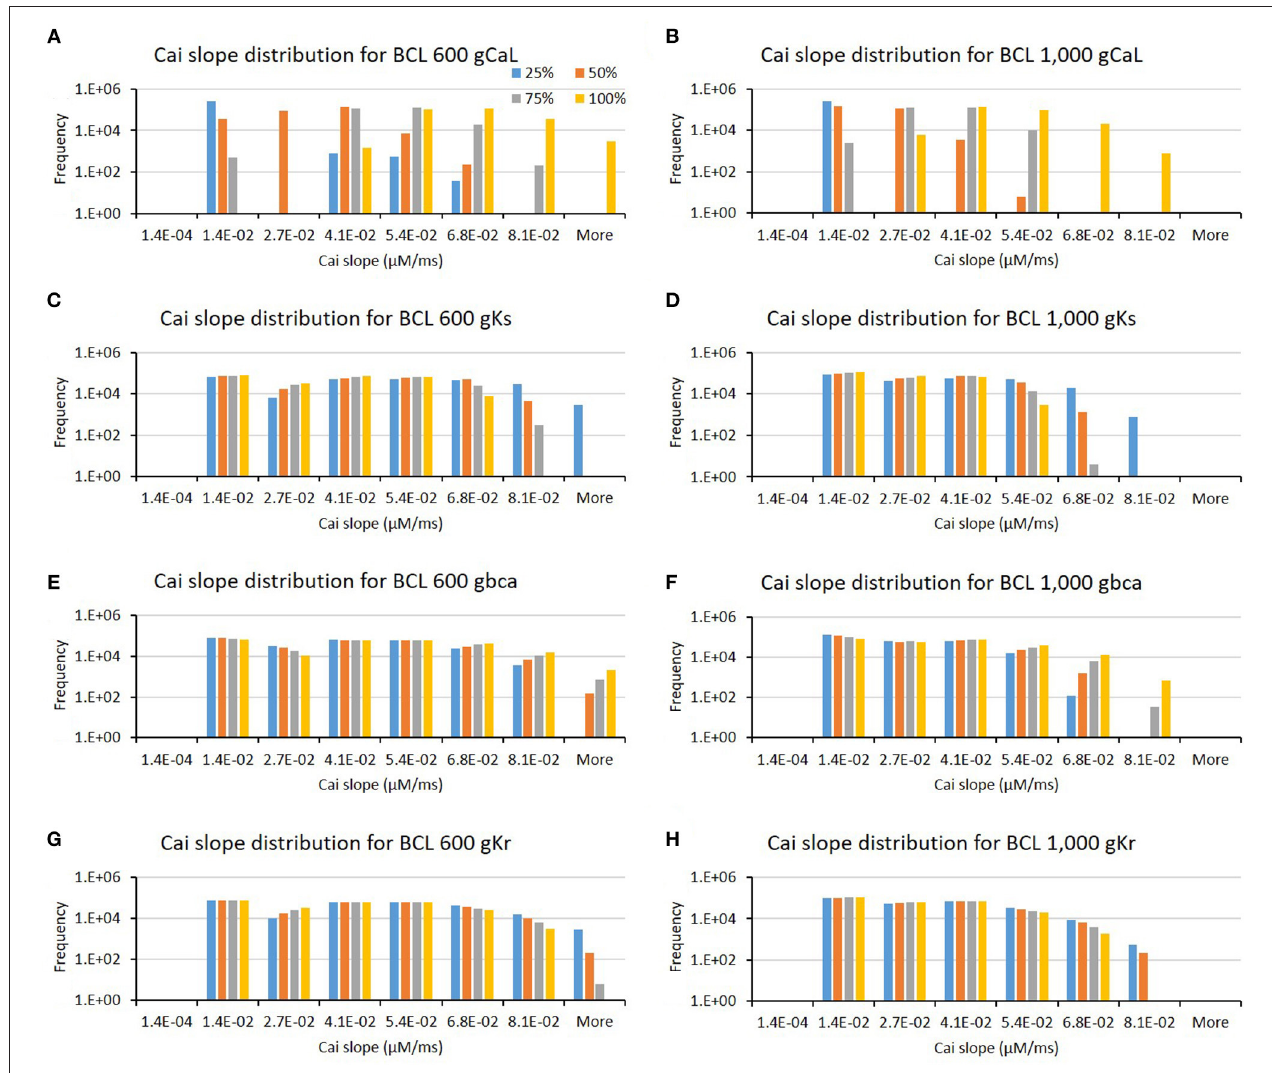
FIGURE 8 | The bar charts show the influence of major ion channels (based on Table 1 ) for changing the Cai slope [for BCL 600ms (A,C,E,G) and for BCL 1,000ms (B,D,F,H) ]. The x-axis is the Cai slope groups in milliseconds, and the y-axis is the frequency (number of appearance of Cai slope groups) in logarithmic scale. Four conductance variations are applied